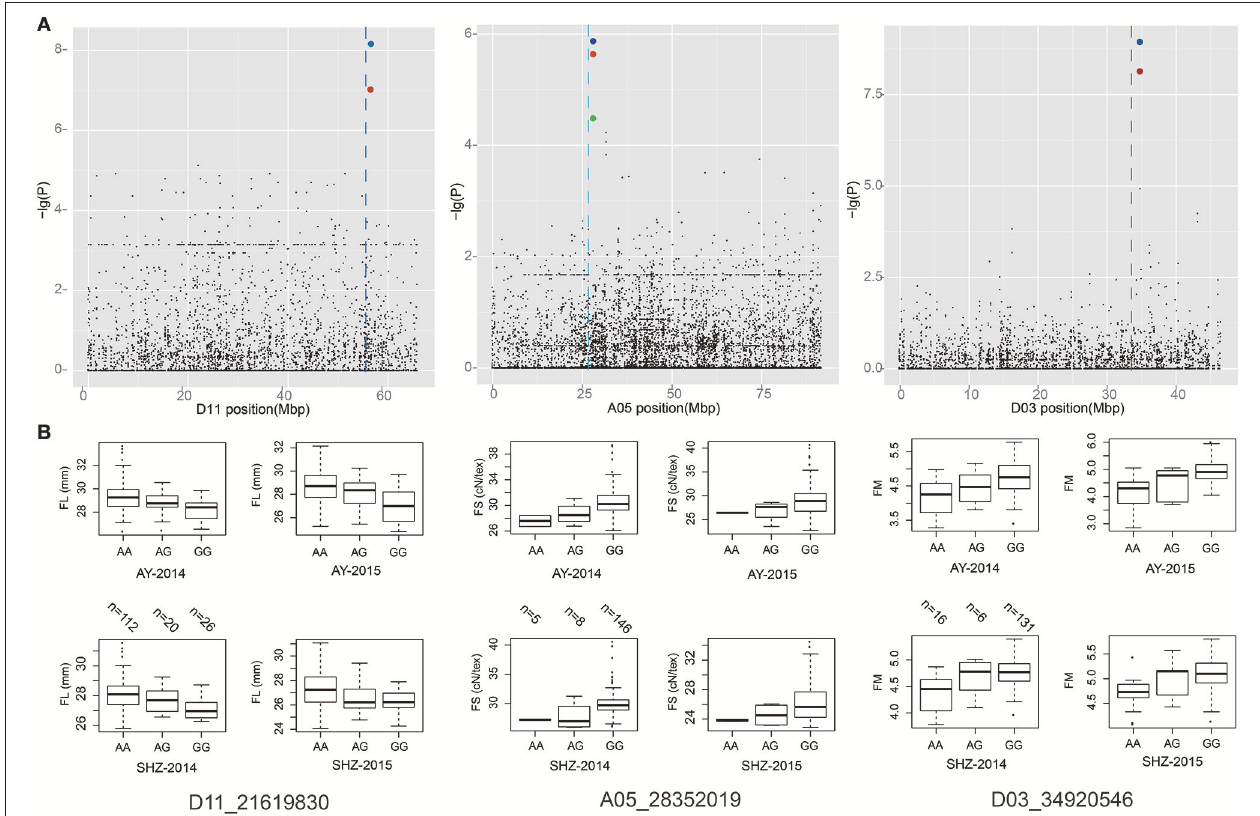
FIGURE 3 | Local Manhattan plot (top), and box plots for the fiber-quality related traits (bottom). (A) Manhattan plots of FL, FS, and FM on chromosome A05, D03, and D11, respectively. (B) Box plots of the significant QTNs (D11_21619830, A05_28352019, and D03_34920546). Each dot represents an SNP. The vertical dashed lines indicate the genomic region containing the significant QTNs. The red and blue circles mark the significant